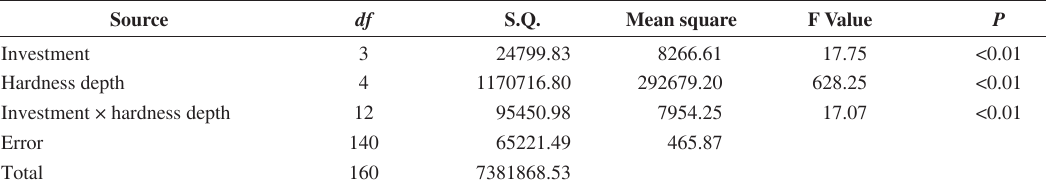
Total Table 4. Vickers hardness mean (VHN), standard deviation, and contrast by Tukey test. Investment